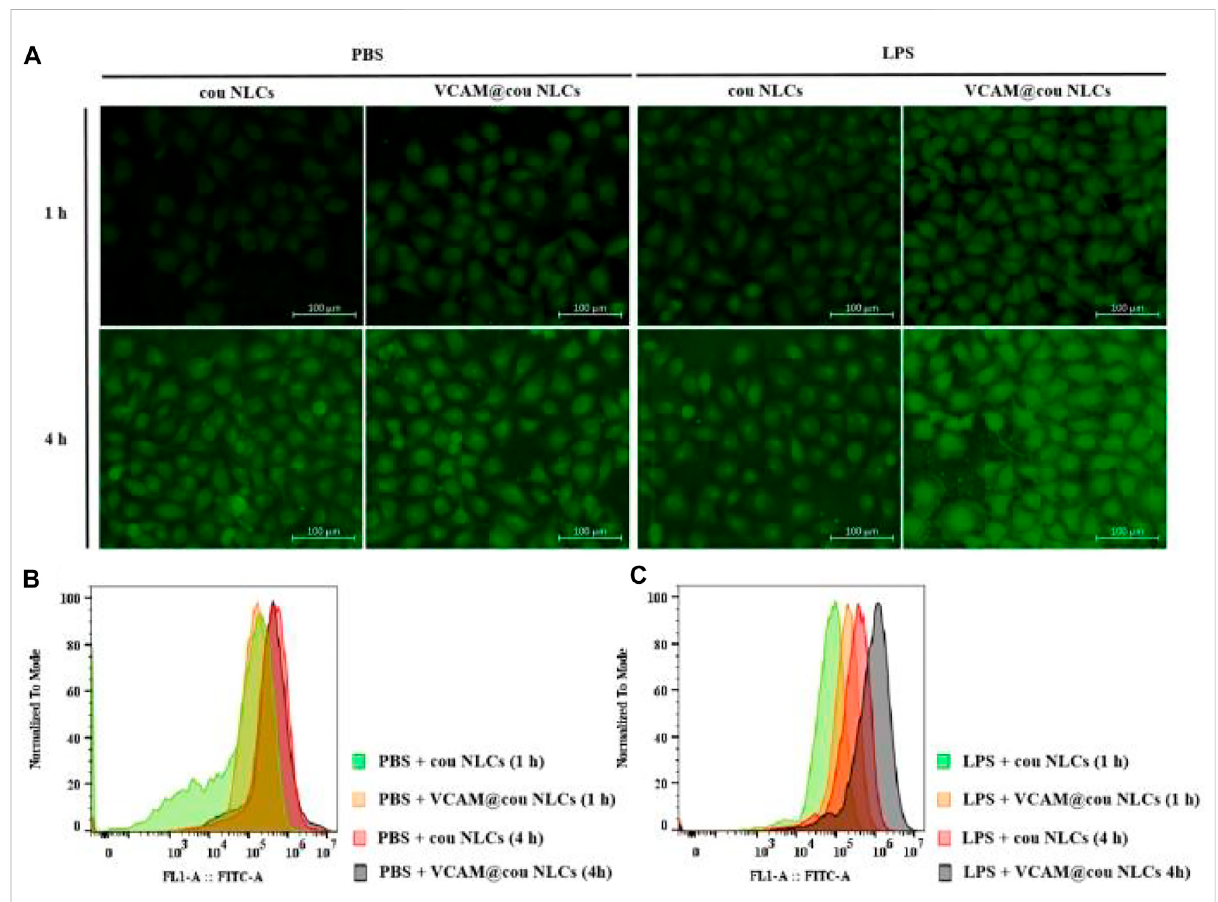
FIGURE 4 Targeted uptake of coumarin-6 (cou)-labelled VCAM-1 antibody-conjugated NLCs (VCAM@cou NLCs) by LPS-induced HUVECs. (A) Representative fl uorescence images of VCAM@cou NLCs internalized by HUVECs after incubated for 1 and 4 h (Scale bar, 100 μ m). (B) and (C) Flow cytometric analysis of VCAM@cou NLCs by